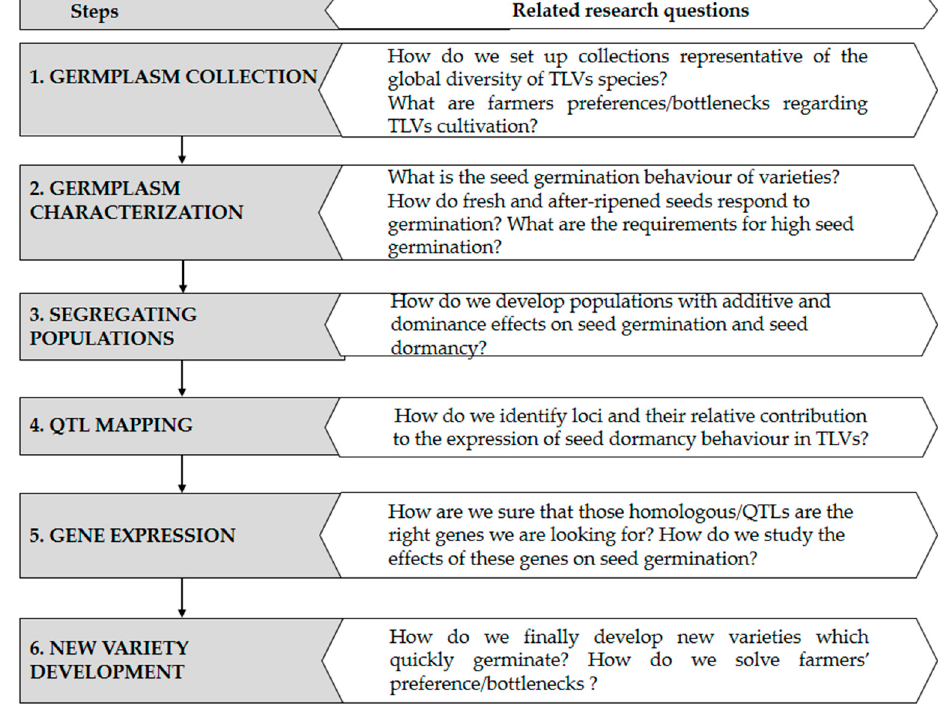
Figure 3. A conceptual approach for seed dormancy study in traditional leafy vegetables (TLVs) species. This proposed research avenue includes germplasm collection, germplasm characterization; development of mapping populations; quantitative trait loci (QTL) mapping; gene expression analysis; and new variety development. Germplasm collection is required in the range of distribution of the species for a developed core collection with cultivated and wild genotypes. Characterization of di ff erent factors influencing seed physiology and dormancy should help establish optimal germination conditions for fresh and after-ripened seeds and assess the natural variation of seed dormancy among genotypes. Development of mapping populations like biparental recombinant inbred lines (RILs), near-isogenic lines (NILs), F2, double haploid (HD), mutants, and multi-parental populations (multiparent advanced generation intercross (MAGIC)), multiparent recombinant inbred lines (AMPRIL)) will help access the genetic background existing among genotypes for seed dormancy. Development of molecular markers and use of modern genomic tools will lead to the successful implementation of mapping approaches such as in silico mapping, Bayesian mapping, linkage disequilibrium, multiple-QTL mapping, interval mapping, single marker-based, and marker regression for TLVs species. Tools such as expressed sequence tags (ESTs), serial analysis of gene expression (SAGE), massive parallel signature sequencing (MPSS), comparative genomics, microarray, and genome-wide association selection (GWAS) should be used for gene expression analysis. The development of improved varieties with high germination ability and many interest traits for farmers will be possible through Marker-assisted gene introgression, ultra-high-density bin map, and marker-assisted gene